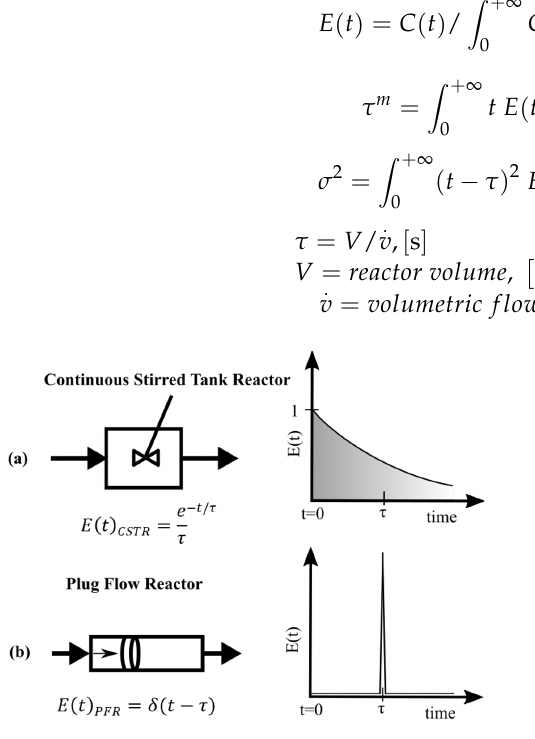
Figure 1. Ideal flow reactors and their RTDs. ( a ) CSTR; ( b ) PFR.